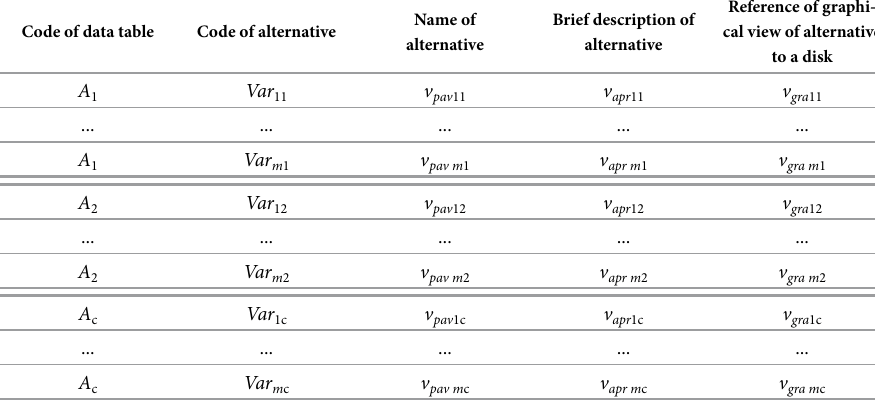
Fig. 2. Diagram of the initial data database (DBS) of construction projects and operations for